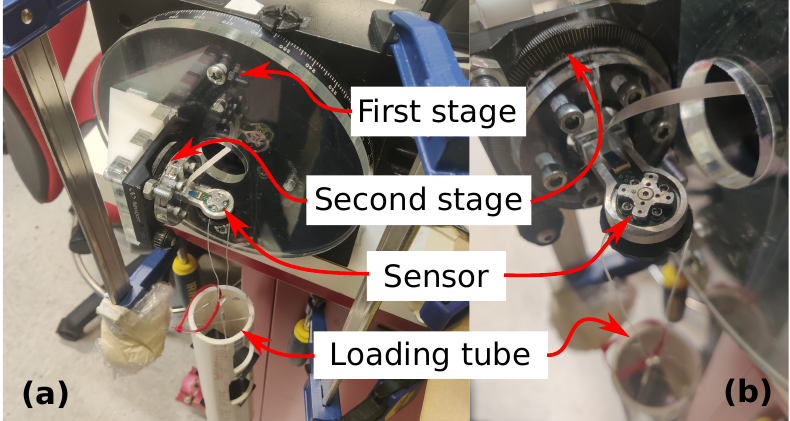
Figure 15. Assembled two-stage loading setup with ( a ) overall view and ( b ) zoomed view of sensor installed in second stage. The second stage is mounted perpendicular to the first stage. The finger assembly is mounted to the second stage such that the sensor’s Z-axis is pointed perpendicular to the normal axis of the second stage. The tension line of the loading tube is secured to the top of the sensor using a custom plastic